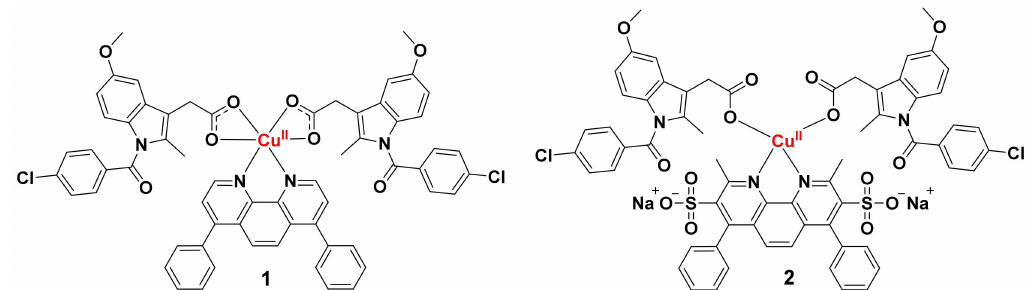
Figure 1. Chemical structures of copper(II) complexes containing a 4,7-diphenyl-1,10-phenanthroline unit and two indomethacin ligands under investigation in this study. The six-coordinate complex, 1 was previously shown, by us, to potently and selectivity kill breast cancer stem cells (CSCs) (over bulk breast cancer cells). The proposed four-coordinate complex, 2 is envisaged to be more stable than 1 towards biological